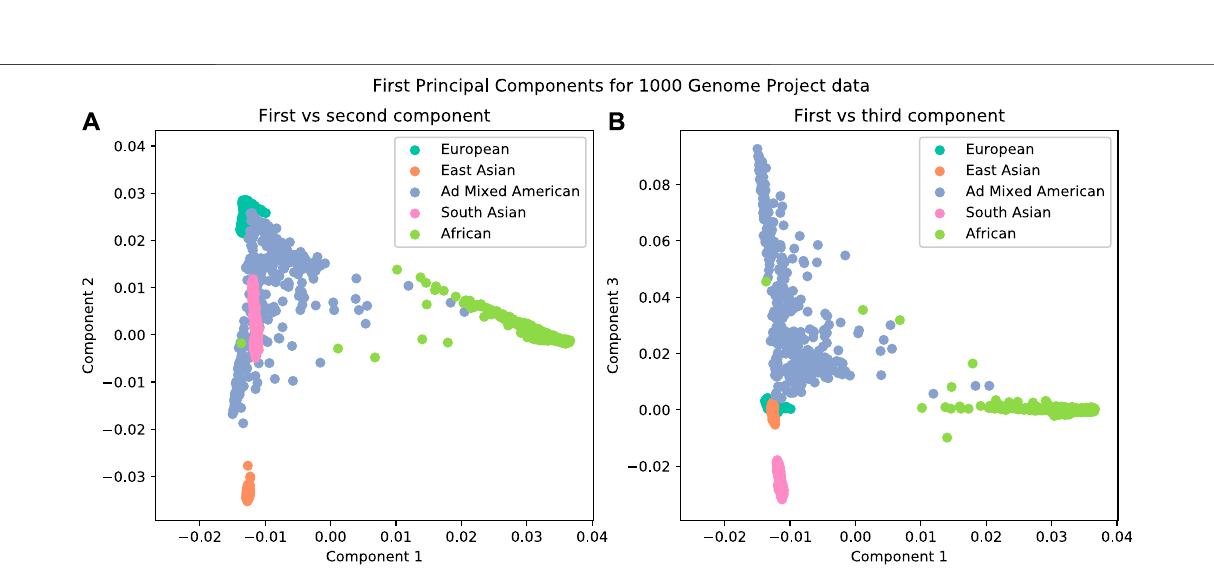
Frontiers in Genetics |